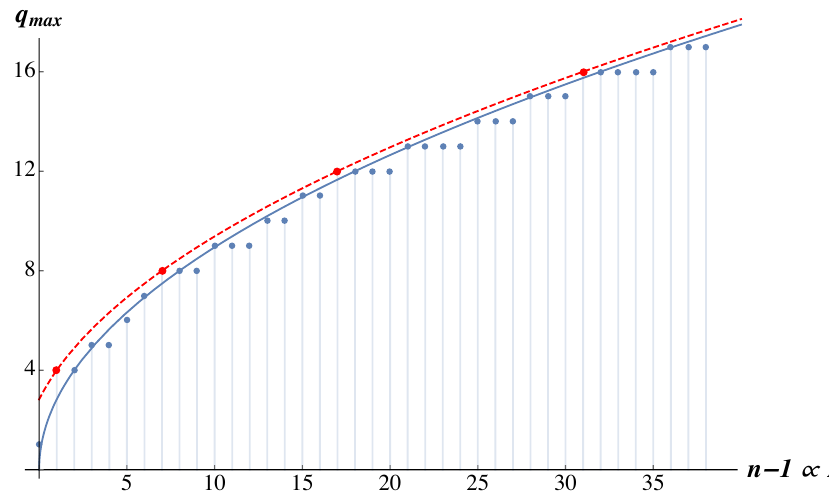
Figure 3 . Maximal charge q max ( n ) for a Bl 1 P 2